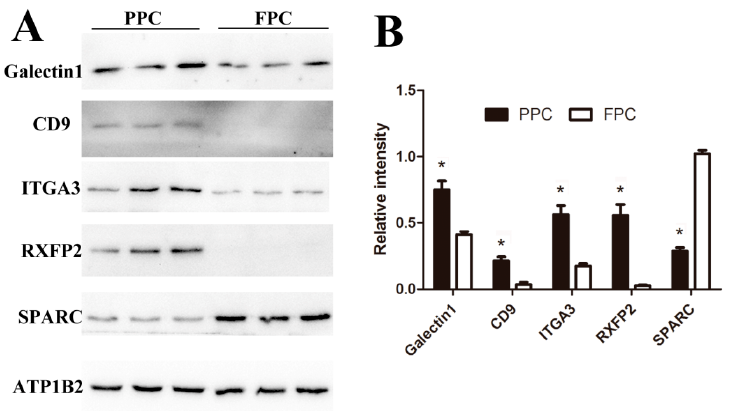
Figure 7. Verification of the DEPs via Western-blot analysis. ( A ) Immunoblot results of five DEPs and internal reference protein (ATP1B2). ( B ) Histogram of immunoblot analyzed using Image J (Version1.8.0, Bethesda, MD, USA) and normalized by ATP1B2. Values are mean ± SD, * p < 0.05.